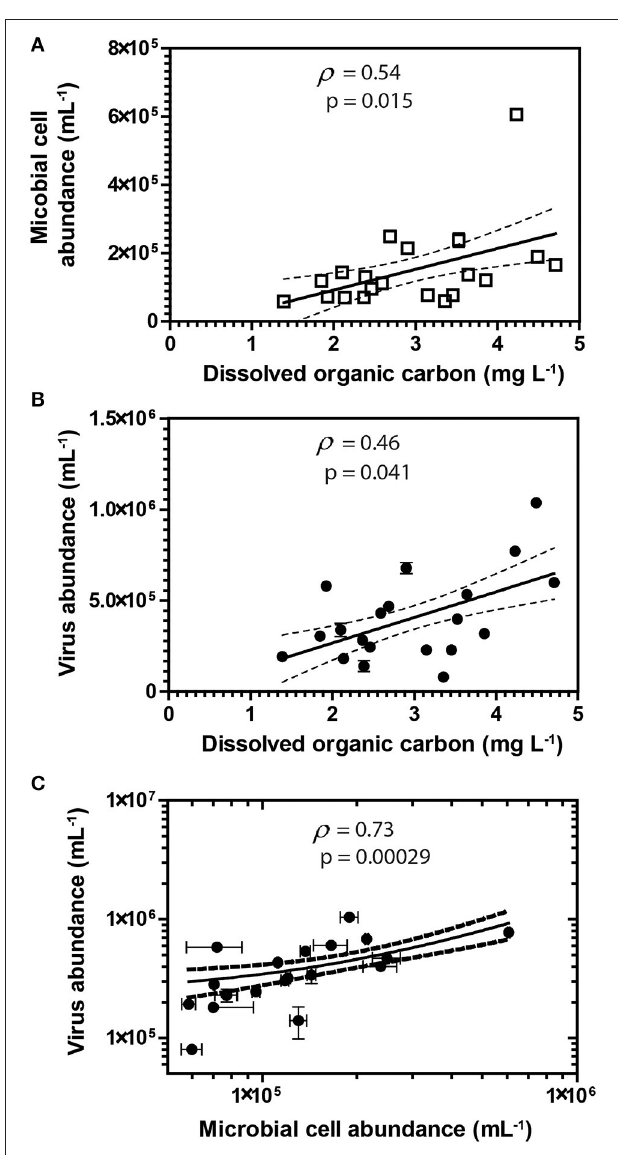
FIGURE 2 | Spearman’s rank correlations between DOC and abundances of cells (A) and viruses (B) . Spearman’s rank correlation between viruses and cells (C) in groundwater samples. Error bars represent the standard deviation of the mean of duplicate measurements. Error bars not visible are smaller than the symbol. Dashed lines represent the 95% confidence interval for the lines of regression presented in the figure.